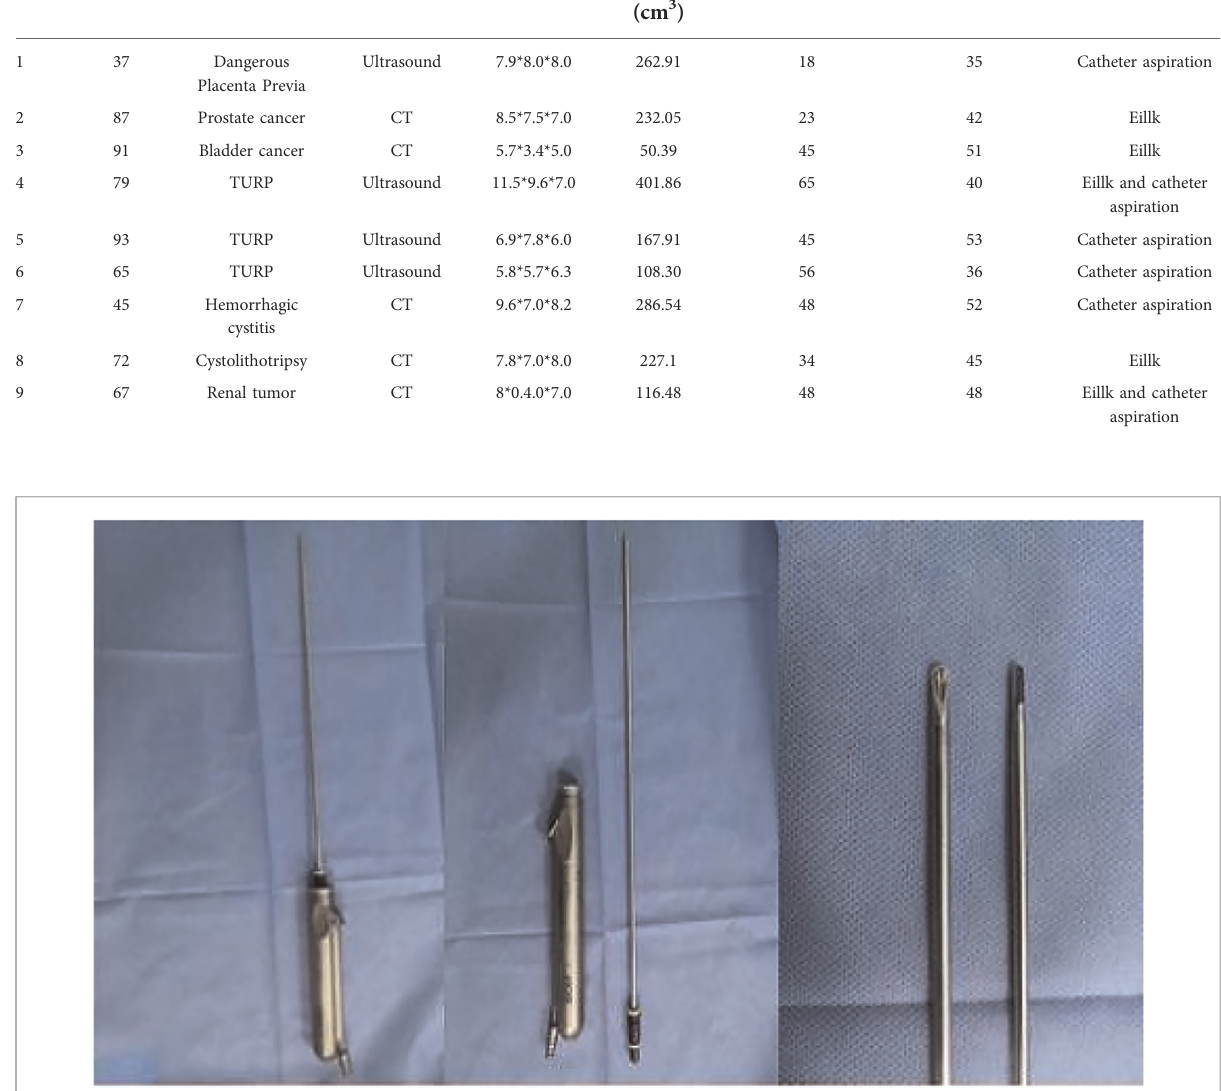
FIGURE 2 A photograph of the